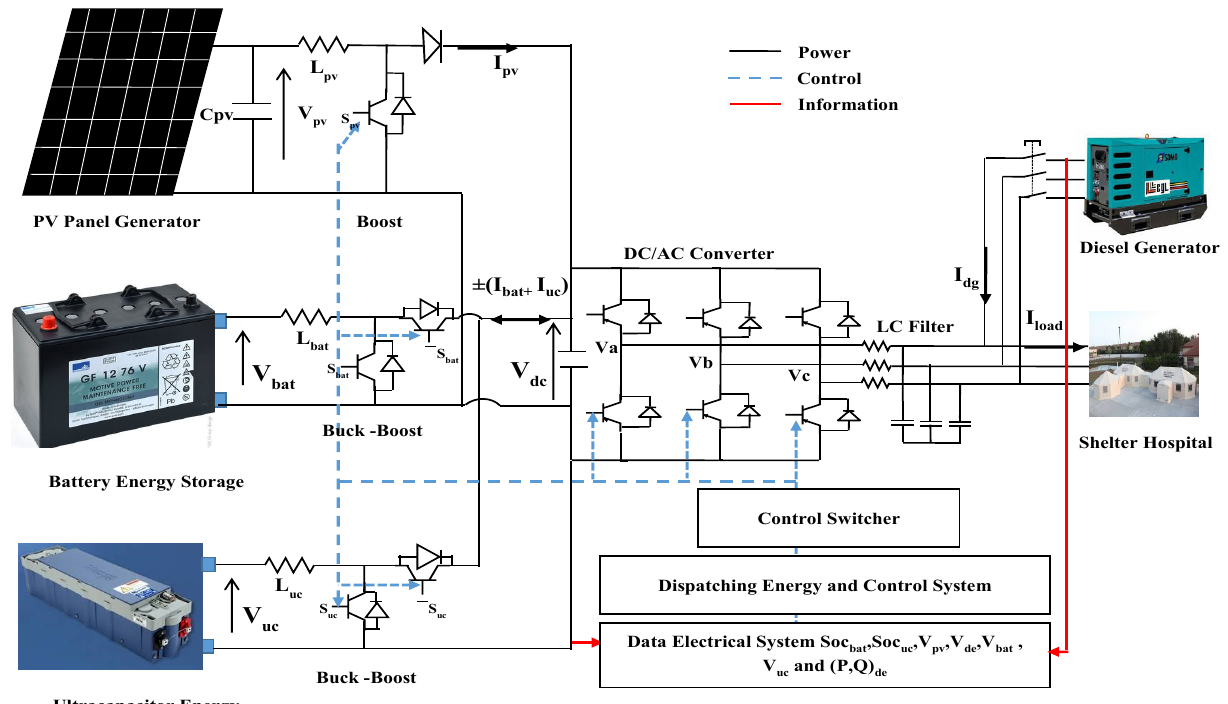
Figure 2. Parallel hybrid power generation system structure for a mobile hospital.